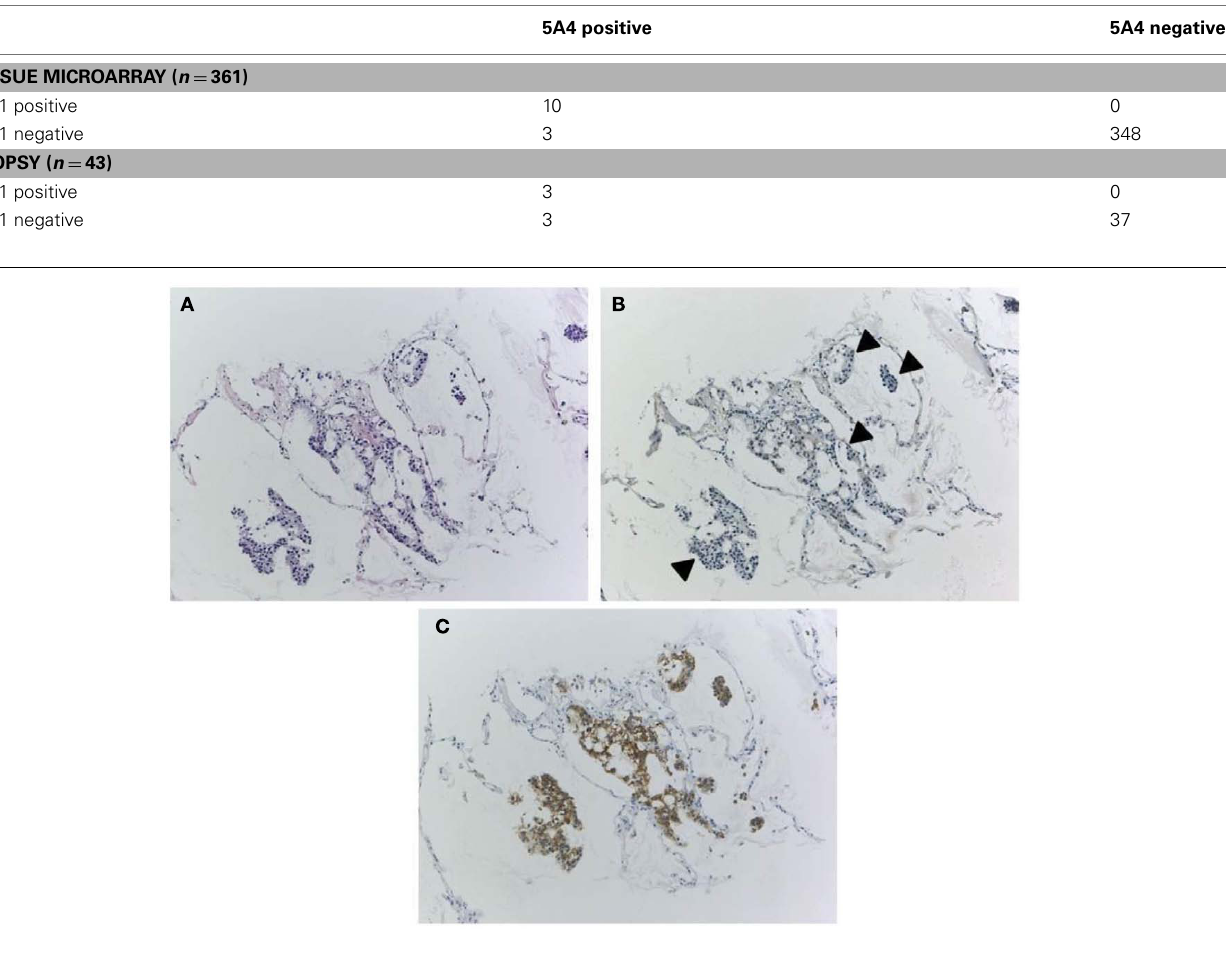
FIGURE 5 | Discordant results according to antibody clones and detection system. A biopsy specimen only contains a small number of tumor cells [H&E staining, (A) ].When ALK1 antibody and conventional detection system was used, IHC showed negative results for tumor cells [ (B) ,